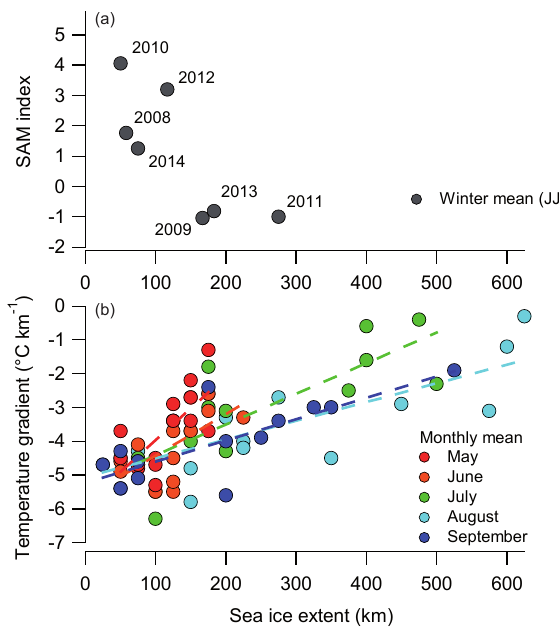
Figure 12. Sea ice extent (SIE) from O’Higgins Station (OH) and its relationship to (a) the Southern Annular Mode and (b) to the temperature gradient between sea level and 1100ma . s . l . at the La- clavère Plateau (LCL). SIE data is from the National Snow & Ice Data Center data set (NSIDC). Sea ice extent, defined as the ex- tension of the oceanic region covered by at least 15% ice, exhibits a negative relationship to the Southern Annular Mode between 2008 and 2014. The relationship to the temperature gradient is positive. A decreasing seasonal pattern of the temperature gradient can be observed from May to September